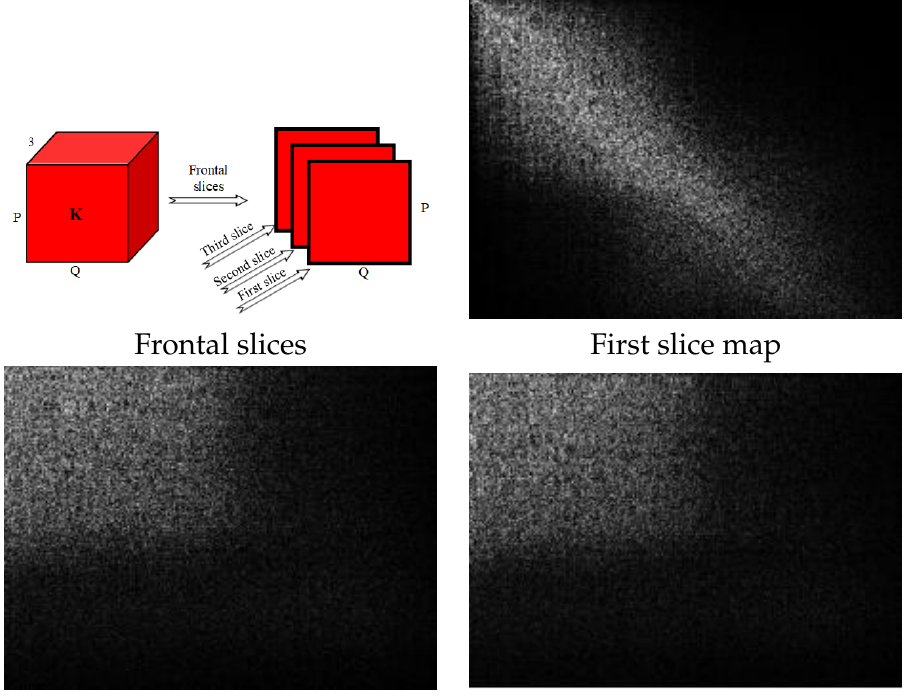
Figure 4. Tensor’s slices map